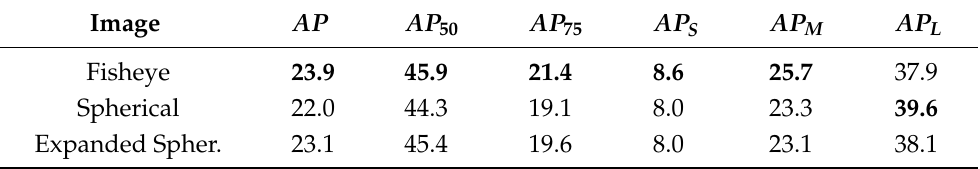
Table 9. Accuracy of different projections of YOLOv3-SPP model on